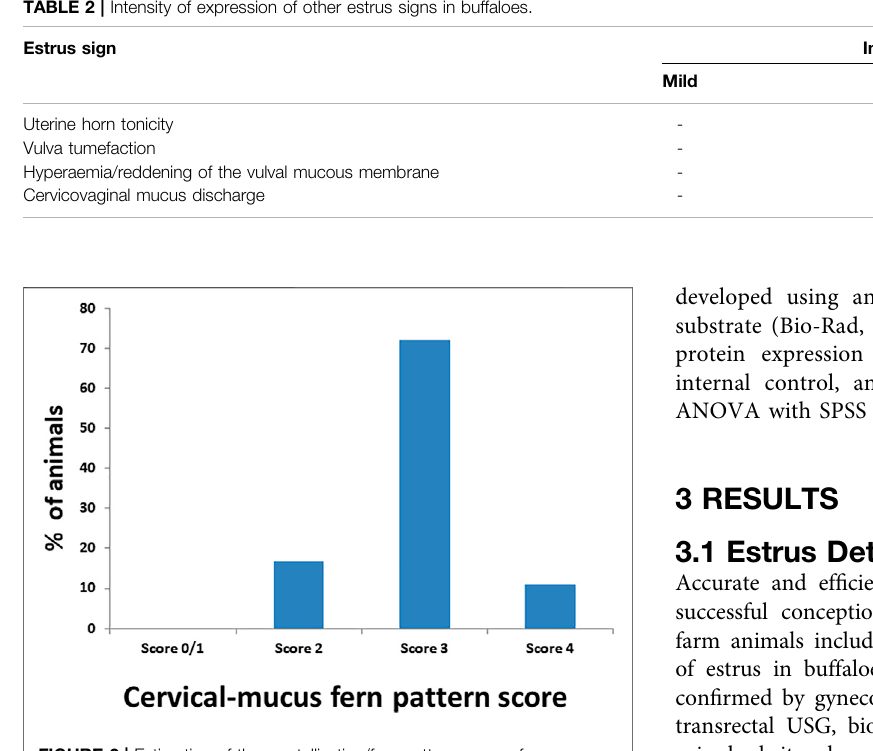
FIGURE 2 | Estimation of the crystallization/fern pattern score of cervicovaginal mucus during estrus in